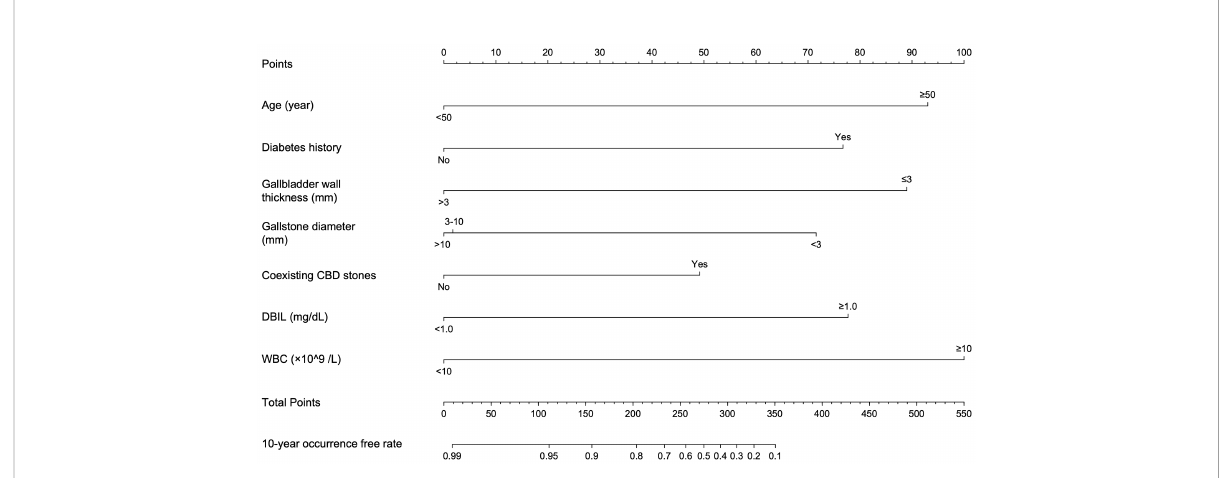
FIGURE 4 Nomogram conducted by Cox regression, including age, diabetes history, gallbladder wall thickness, gallstone diameter, coexisting CBD stones, DBIL and WBC in patients with symptomatic gallstones.